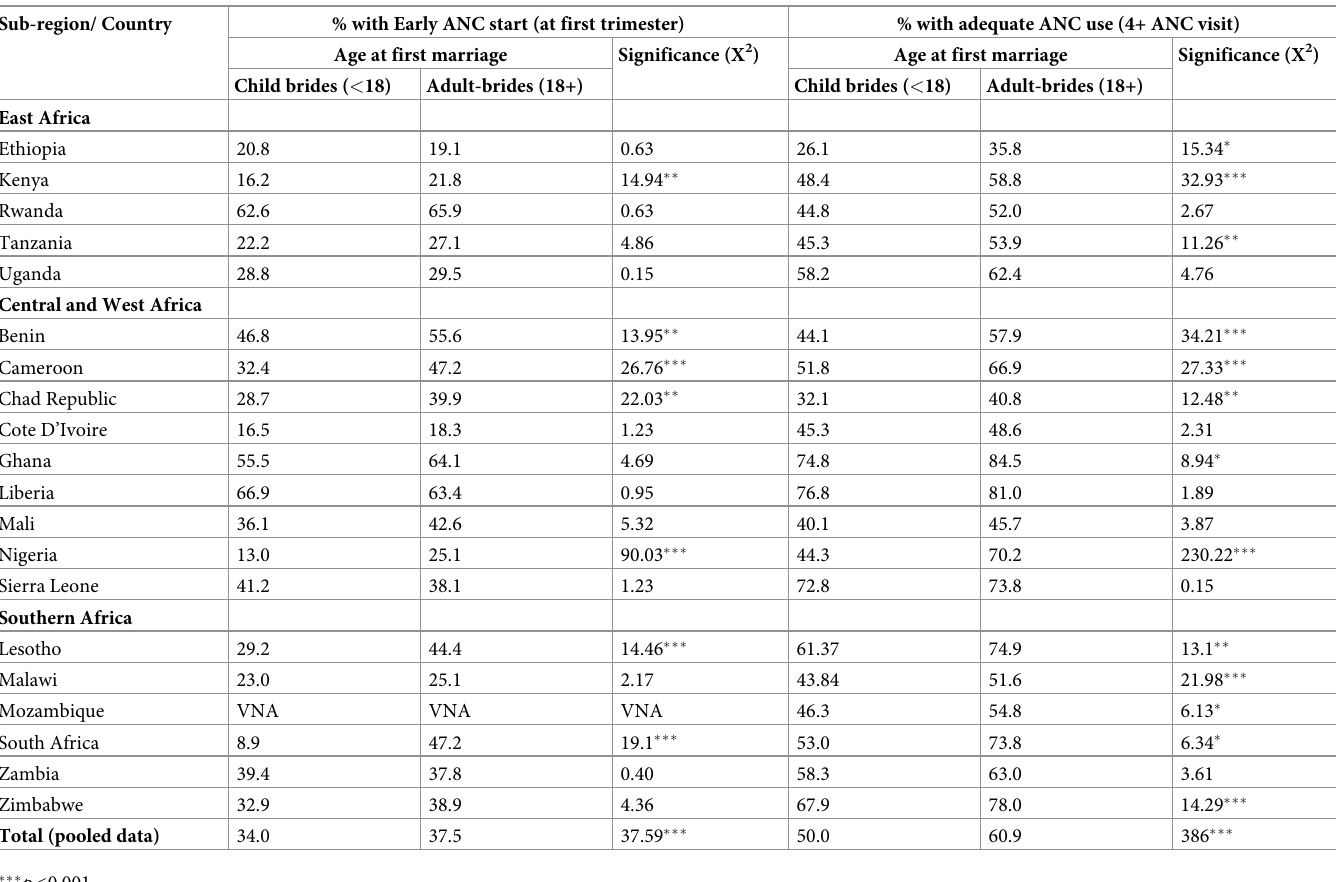
Table 2. Percentage distribution of study participants aged 20–24 according to the timing of first ANC visit and number of ANC visit by selected SSA countries. Sub-region/ Country